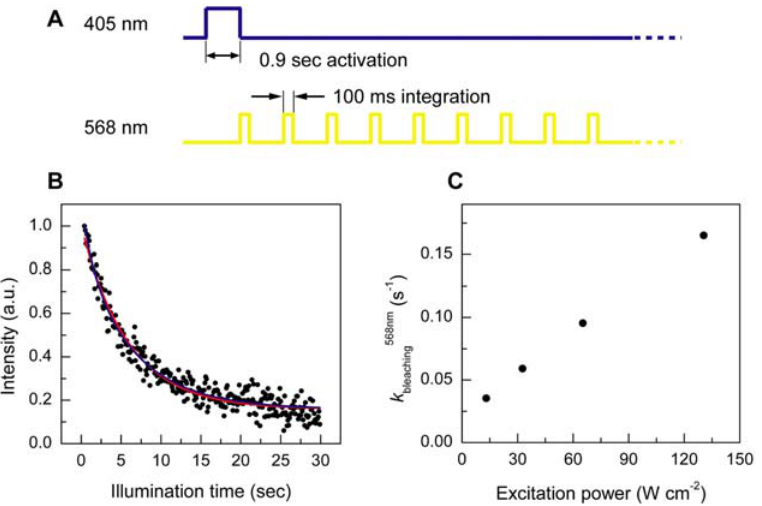
Figure 6. Single-molecule photobleaching of mKikGR. (A) Schematic illustration of experimental configuration. The excitation power of the 405 nm and 568 nm lights were set at 6.3 and 130 W cm 2 2 , respectively. (B) Time course of the fluorescence intensity of the red mKikGR embedded in polyacrylamide gel (100 pM, pH 7.0). The red and blue lines show a single- and double-exponential fit. (C) Excitation power dependence of the photobleaching rates of the red mKikGR.